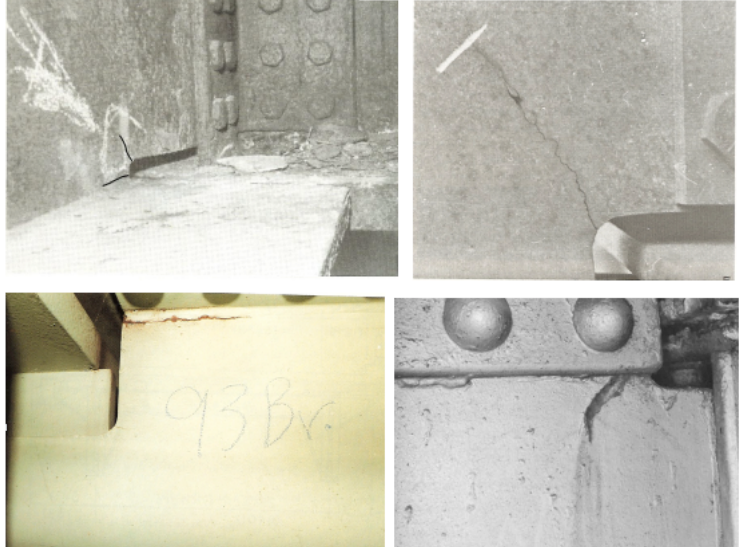
Figure 21. Examples of fatigue cracking in various bridge elements with coped ends or cut-short flanges (after